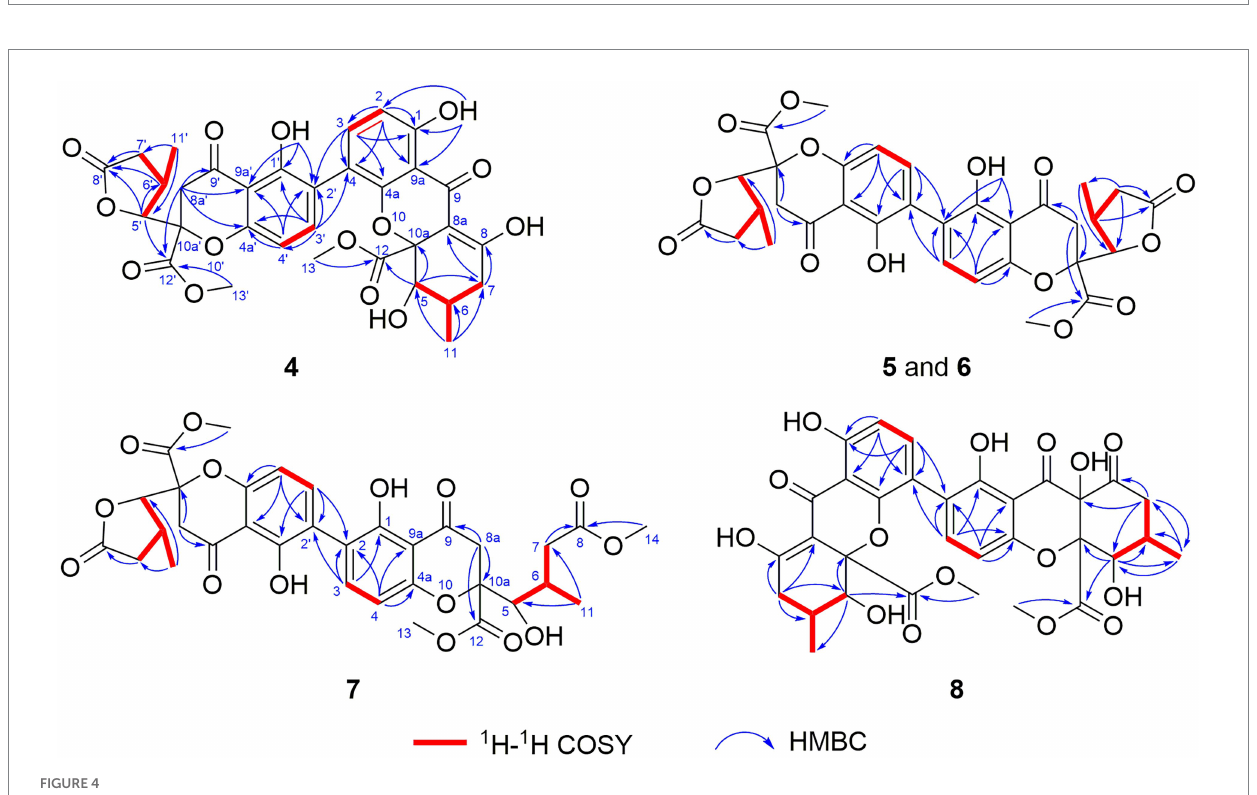
FIGURE 4 1 H- 1 H COSY and HMBC correlations of 4 – 8